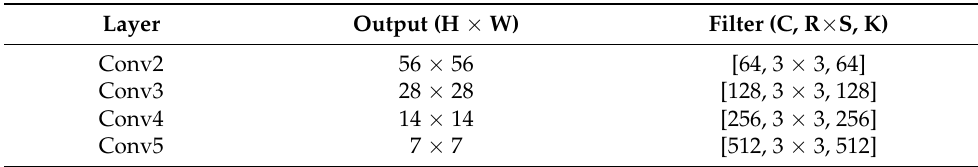
Table 2. ResNet 3 × 3